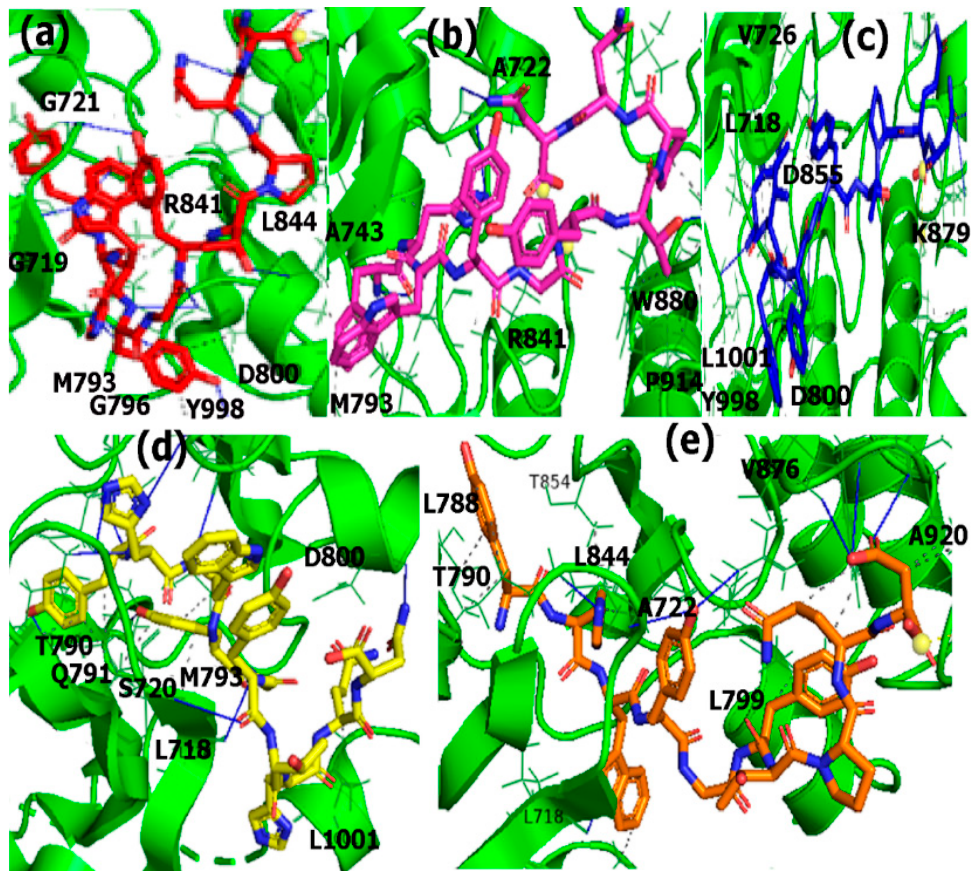
Figure 6. PLIP results for each of the peptides bound to EGFR receptor. ( a ) Original peptide; ( b ) Mut1 ( c ) Mut2 ( d ) Mut3 ( e ) Mut4 .